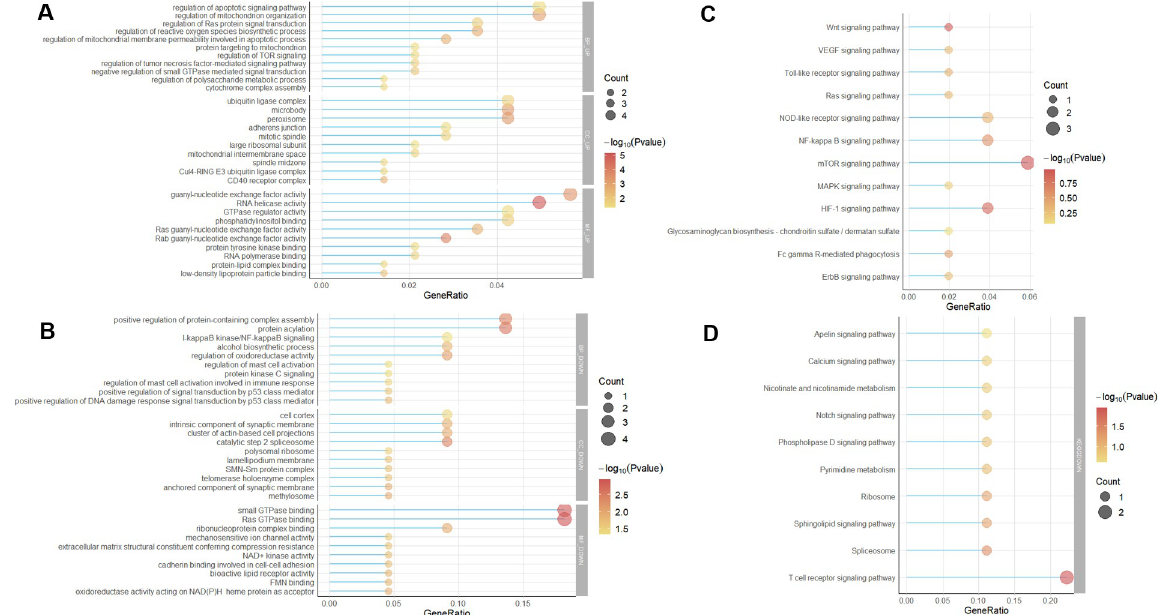
Fig 5. Baseball figure of differential gene enrichment analysis. The horizontal axis represents the proportion of differential genes in GO and KEGG enrichment analysis, and the vertical axis represents the enrichment category. (A)Up-regulated GO enrichment distribution of differentially expressed genes (B) Down-regulated GO enrichment distribution of differentially expressed genes (C) Up-regulated differential gene KEGG enrichment distribution (D) Down-regulated differential gene KEGG enrichment distribution.